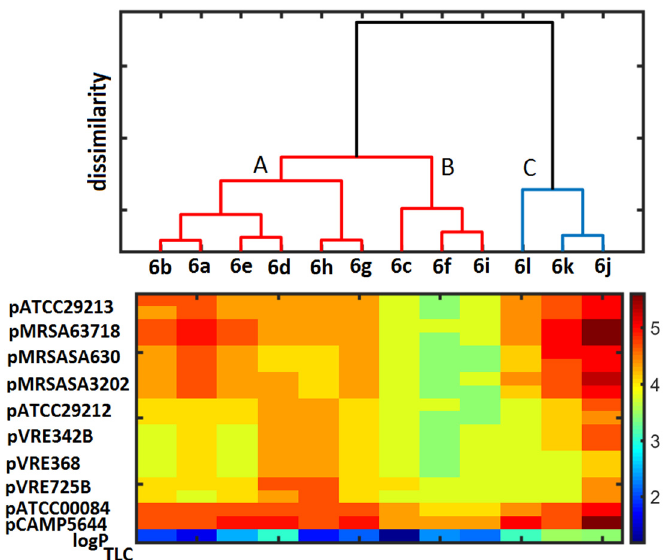
Figure 4. Dendrogram of molecules 6a – l in descriptor-based space with colour-coded map of bio- logical and lipophilic data in logarithmic scale.